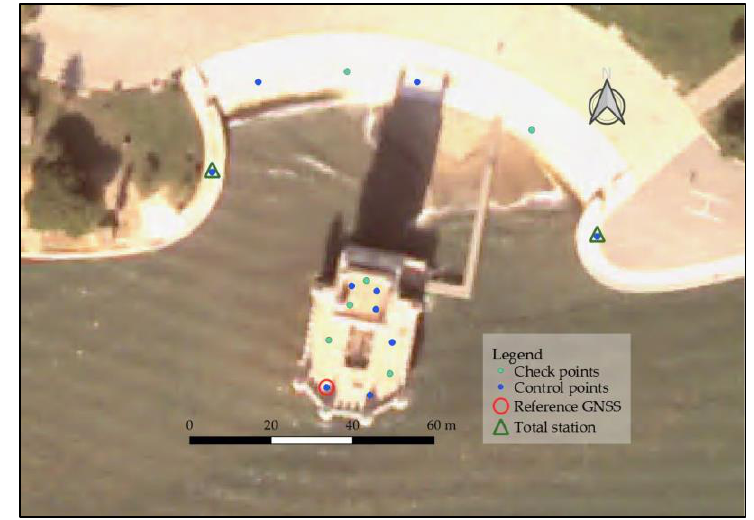
Figure 11. Location of control and check points.